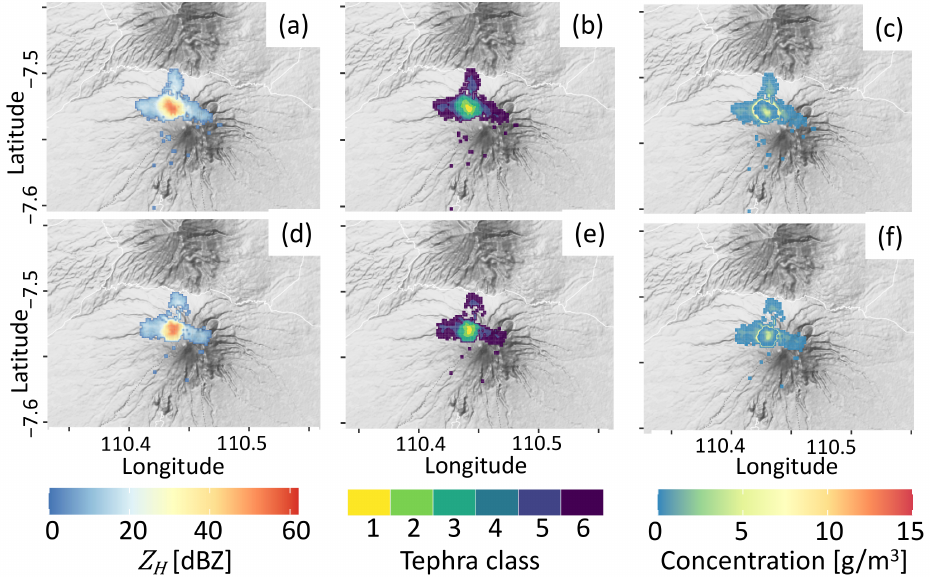
Figure 2. Tephra detection using modified VARR model (Appendix A and Appendix B) for M05 (first row) and M06 (bottom row) at 2 min after the reported eruption onset. From the left, the first column ( a , d ) is the reflectivity intensity factor, the second column ( b , e ) is the tephra classes, and the third column ( c , f ) is the tephra concentration. Tephra classes ( b , e ) of 1–3 represent the coarse class (C) of light, moderate, and intense concentration, respectively. Tephra classes of 4–6 represent the same tephra concentration, but for the finer class